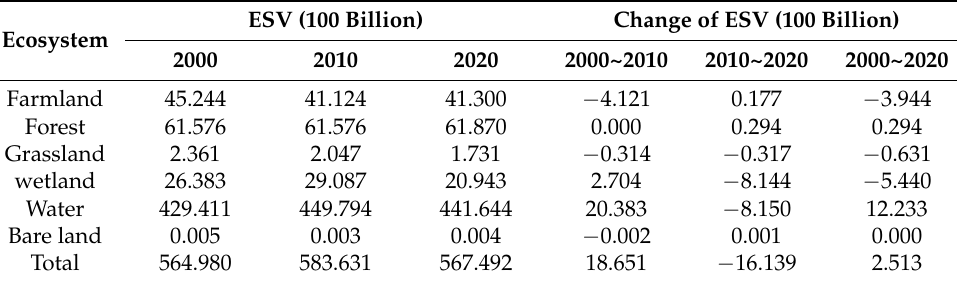
Table 5. Changes in ESVs by category in Wuhan during 2000–2020 (CNY). ESV (100 Billion) Change of ESV (100 Billion) Ecosystem 2000